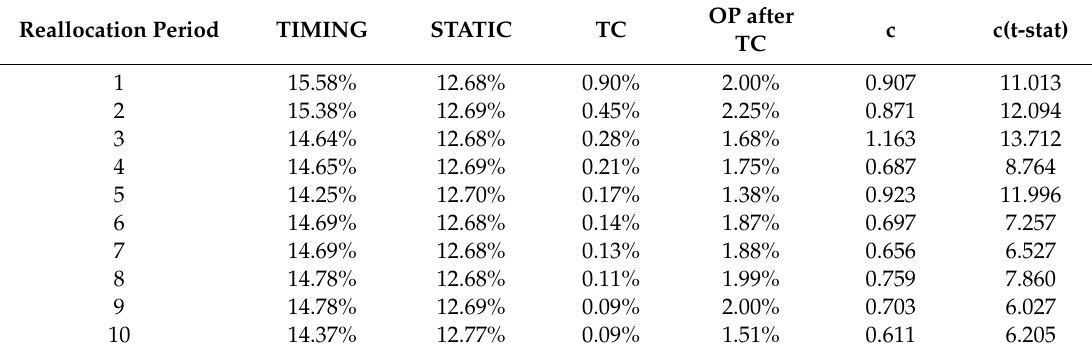
Table 5. Investment strategy and transaction costs.